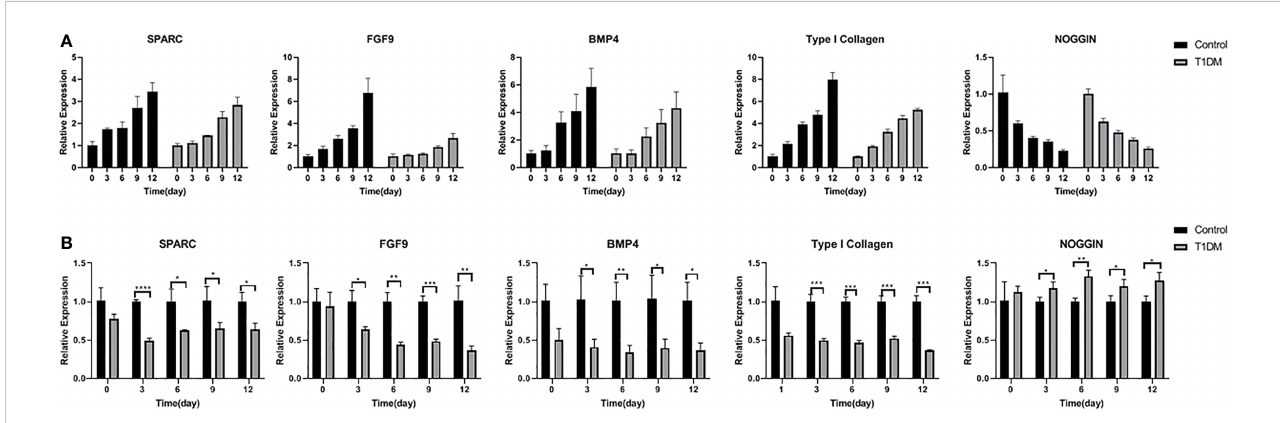
FIGURE 7 The relative expression of SPARC, FGF9, BMP4, Type I collagen and NOGGIN in control and T1DM group on days 0, 3, 6, 9, and 12 of the experiment. (A) The trend of relative expression levels in both groups at days o,3,6,9,12. Extraction of the opposing teeth resulted in a gradual increase in SPARC, FGF9, BMP4, and Type I collagen relative expression while the expression level of NOGGIN decreased, indicating that these osteogenesis-related factors were actively involved in bone remodeling during the axial tooth movement. (B) Comparison of the relative expression levels in two groups at different time points. The relative expression levels of SPARC, FGF9, BMP4, and Type I collagen were lower, and the NOGGIN expression was higher in T1DM mice compared with control mice, suggesting that osteogenesis was impaired in T1DM mice. *P < 0.05; **P < 0.01; ***P < 0.001; ****P < 0.0001.